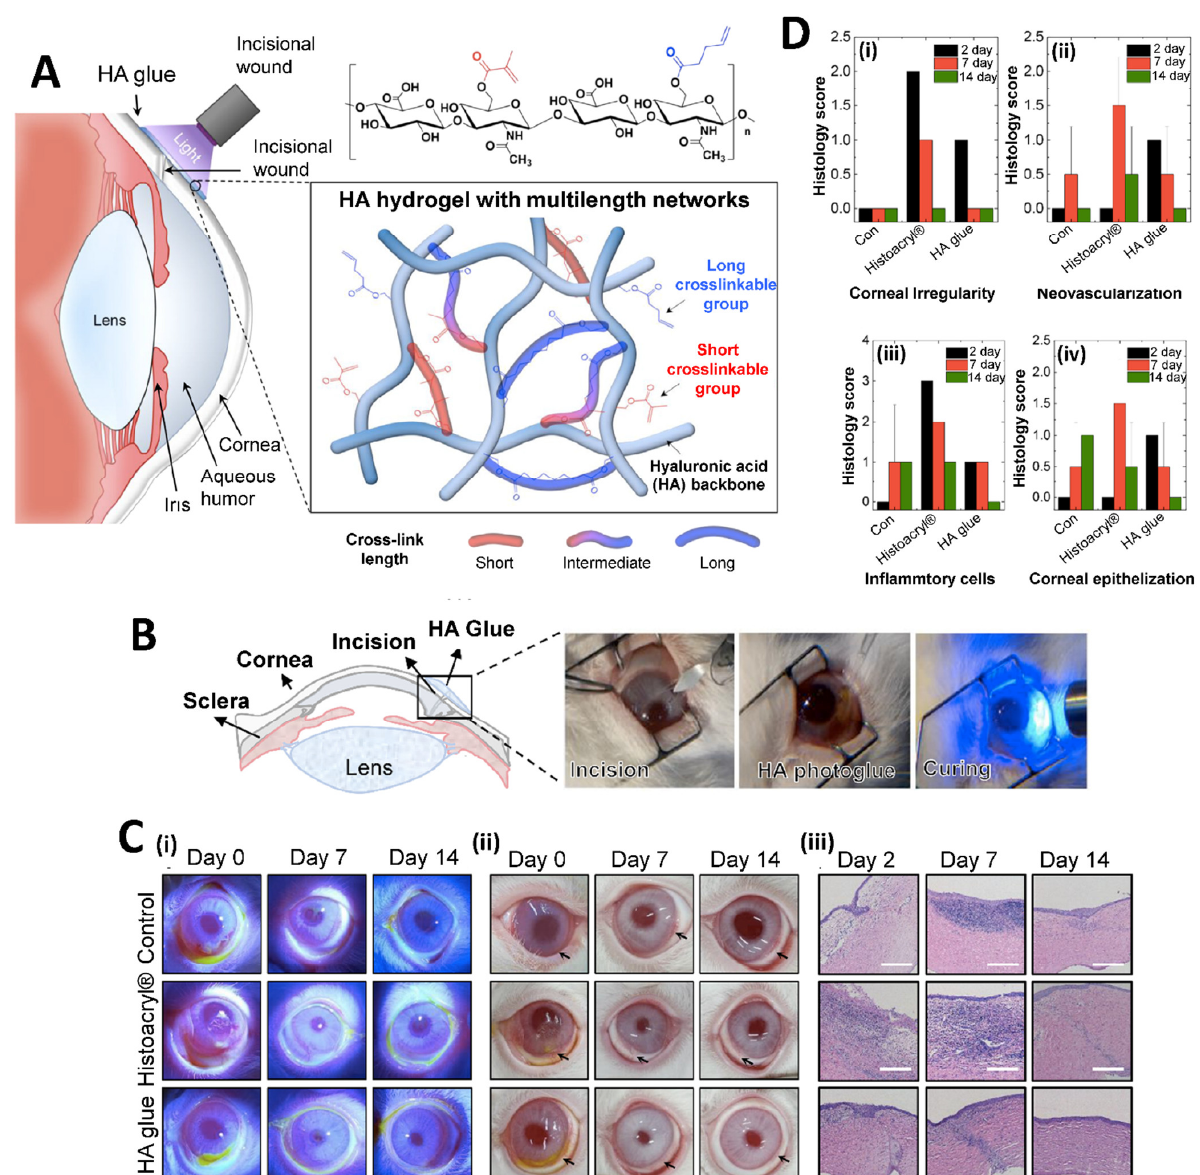
Figure 5. Illustration of the structure of photo-crosslinkable HA Tas and its application practice ( A ), images of in vivo experimental procedure for sealing of rabbit corneal incision using HA Tas ( B ), photographs at different time points after the incision and histological images (Scale bar: 250 μm) ( C ) and histological scores. The scores are referred to as follows: 3 (Severe), 2 (Moderate), 1 (Mild), and 0 (Negligible) ( D ). Reprinted from [129].